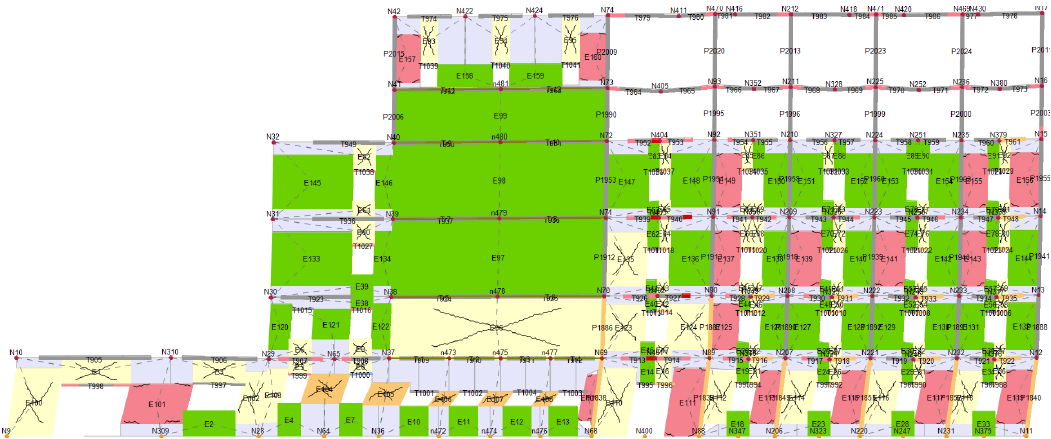
Figure 18. Structural damage wall n.1 at the last step of seismic analysis n.1, direction X (Modal forces).